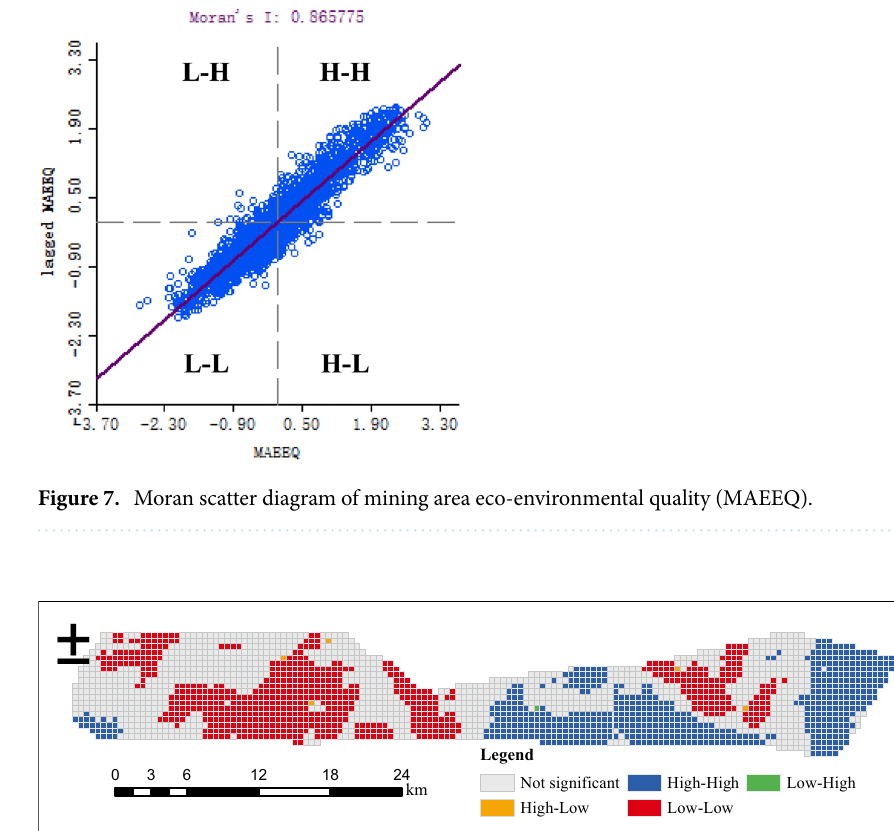
Figure 8. LISA aggregation diagram of eco-environmental quality. The Figure is created by GeoDa ver.1.20 (http:// geoda center. github.